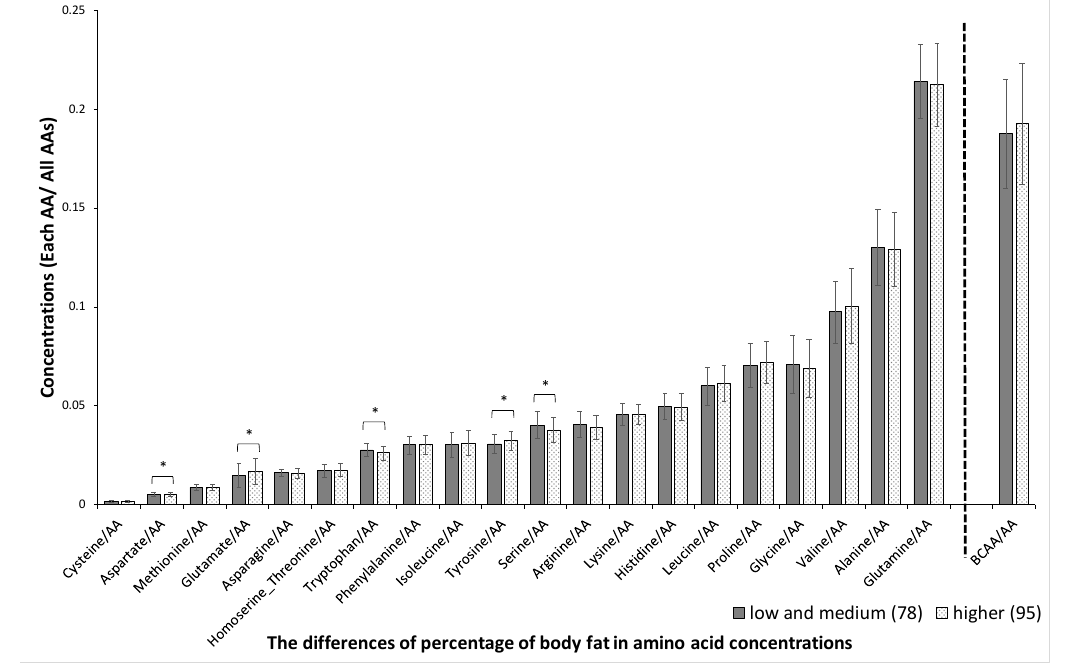
Figure 4. Body fat percentage-related differences in amino acid concentrations. The absolute concentration was divided by the total AA concentration, yielding the relative concentration. Participants were divided into two groups based on body fat percentage, 25% in men and 30% in women. AAs, amino acids; BCAAs, branched-chain amino acids. * p < 0.05, ** p < 0.01 in body fat percentage < 25% versus body fat percentage ≥ 25% in men and in body fat percentage < 30% versus body fat percentage ≥ 30% in women .